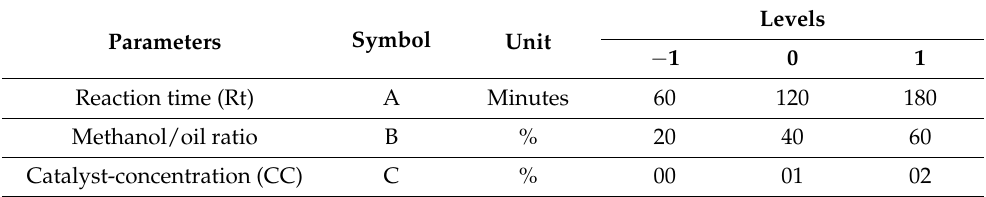
Table 2. Blend oil transesterification via BBD with independent parameters. Parameters Symbol